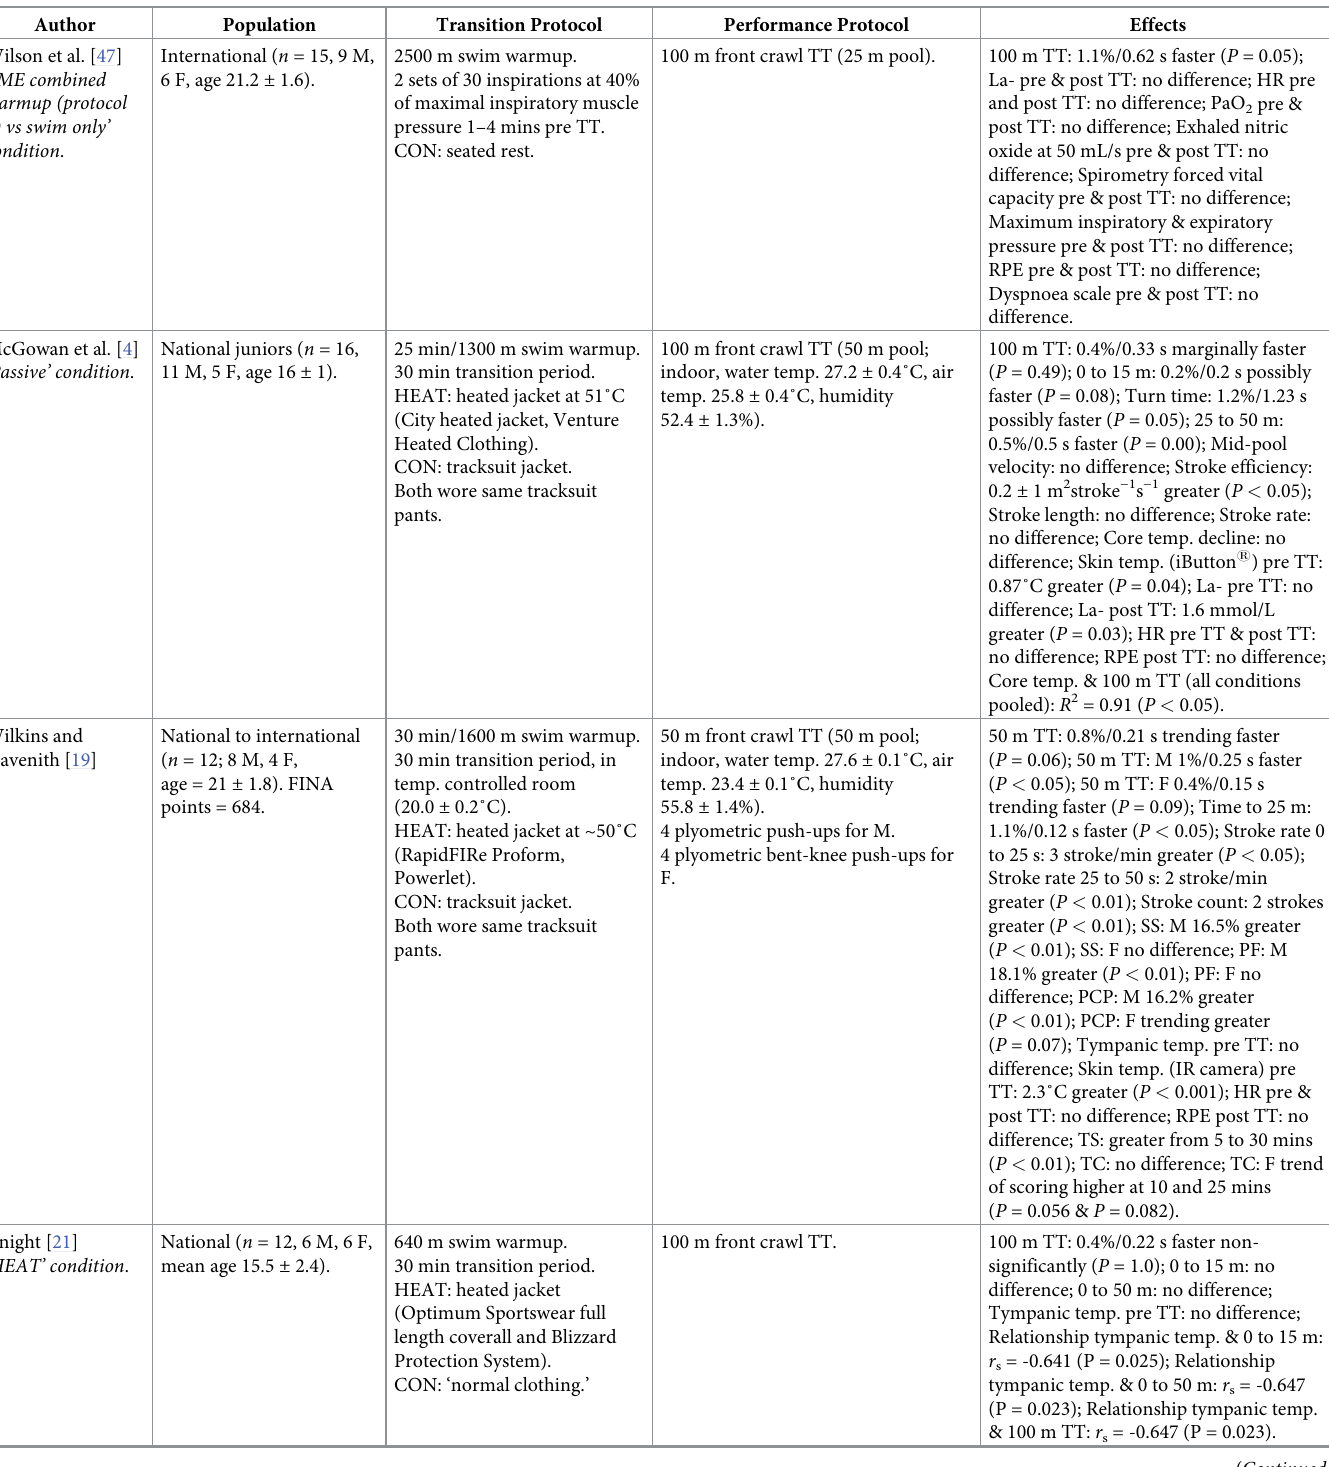
Table 3. Passive